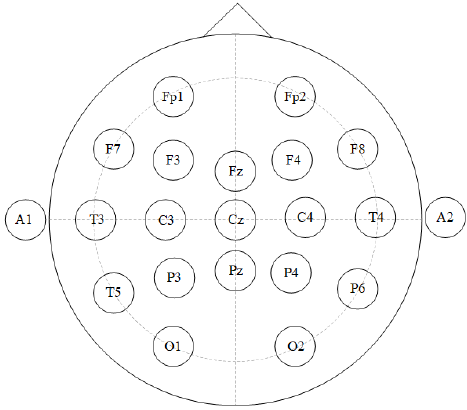
Figure 2. Layout of EEG electrodes. Table 1. Description of samples and patients employed in TUH Abnormal EEG Corpus